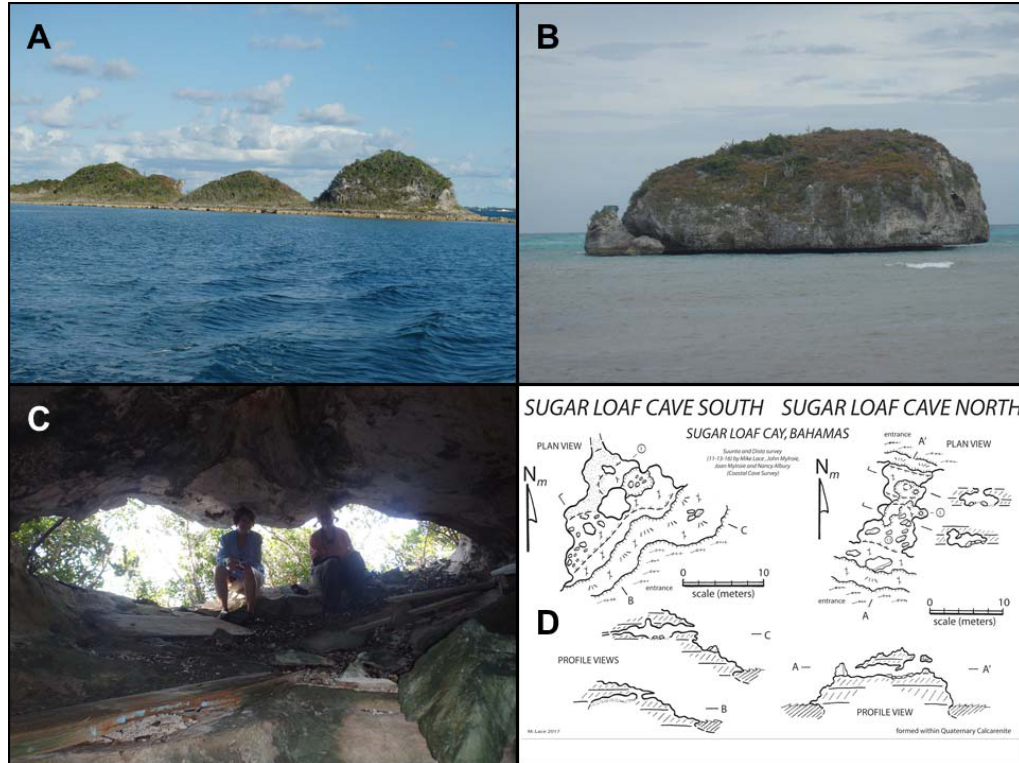
Figure 6. Evidence for geochemically ‐ active freshwater lenses in small islands. ( A ) The right hill in the image is Sugar Loaf Cay, Abaco, approximately 10 m high. It would have been an isolated island at the +6 m sea ‐ level of MIS 5e. ( B ) Small cay offshore Middle Caicos Island provides a present ‐ day model for the condition of Sugar Loaf Cay during MIS 5e. The bioerosion notch visible in this cay is not present on Sugar Loaf Cay, a result of surface denudation in the 115 ka since MIS 5e. ( C ) Main chamber of Sugar Loaf Cave North, a flank margin cave. ( D ) Map of Sugar Loaf Cave North. The entrances have formed as a result of surface denudation of Sugar Loaf Cay since MIS 5e (or 115 ka); the cave originally formed as a sealed chamber.